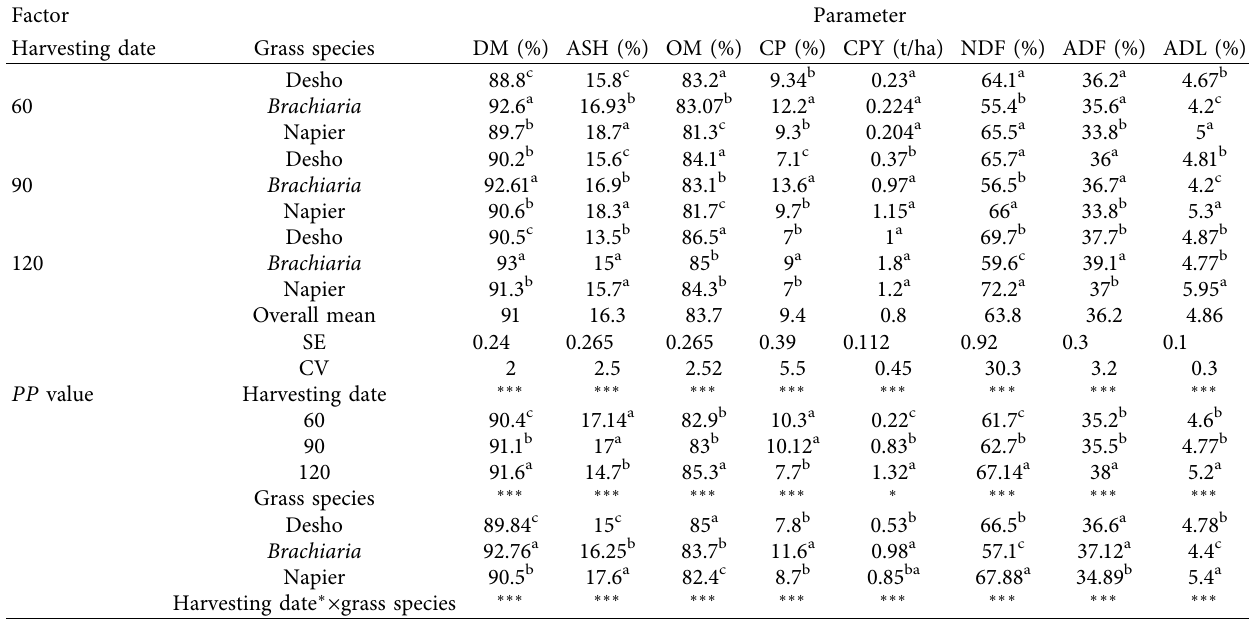
Table 2: Effect of harvesting stage and improved grass species on chemical composition of the grass.